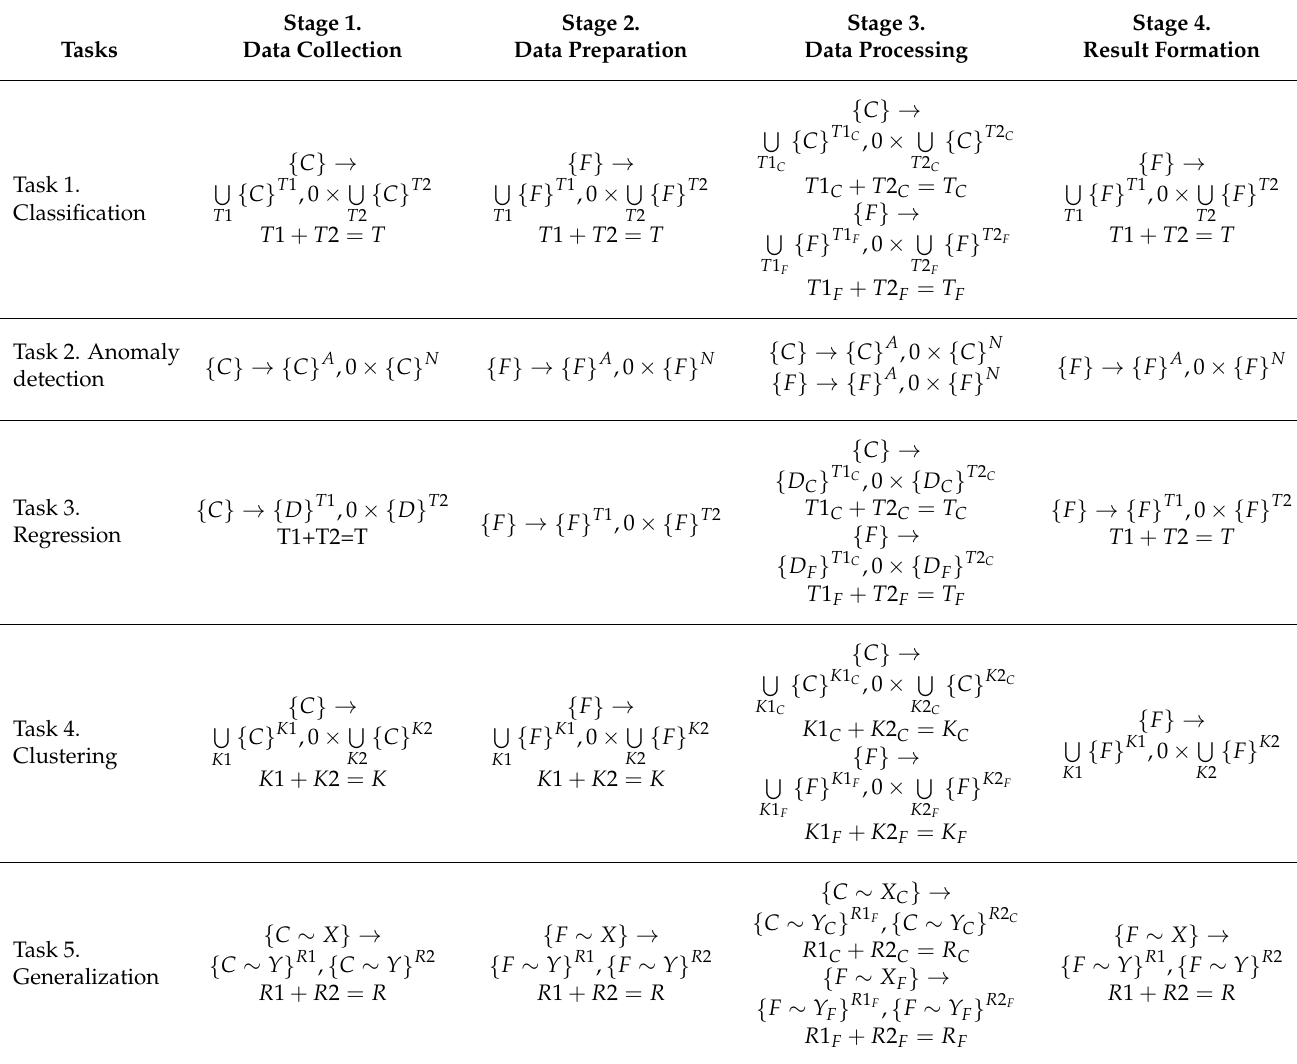
Table 2. Machine-learning decision matrix for static analysis stages.